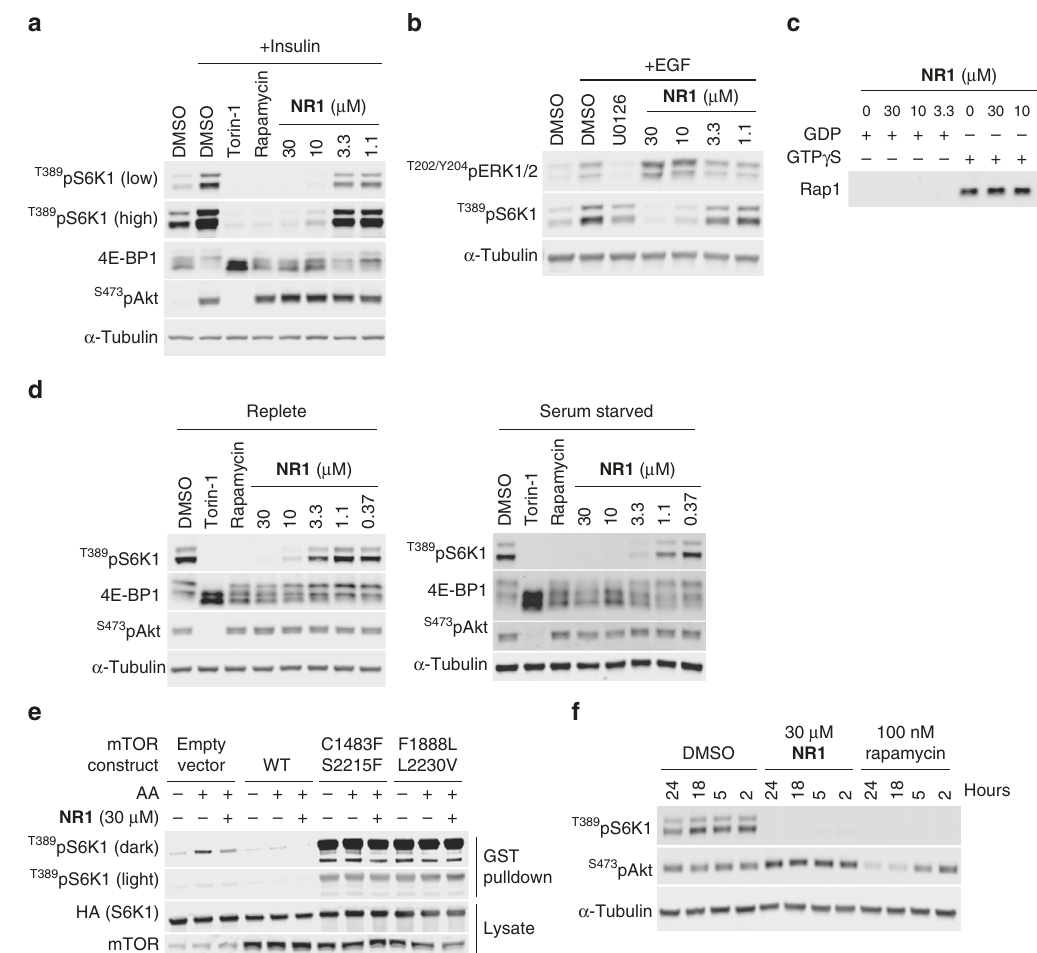
Fig. 4 NR1 selectively inhibits mTORC1 but not mTORC2 in cells. a , b Effect of NR1 on insulin-dependent activation of mTORC1 and EGF-dependent activation of T202/Y204 pERK1/2. MCF-7 cells were serum-starved for 16 h and treated with compound for 90 min before cell lysis and Western blot analysis. For insulin-stimulated cells, 100 nM insulin was added 30 min before cell lysis. For EGF-stimulated cells, 100 ng mL − 1 EGF was added 10 min before cell lysis. c Rap1 activity was detected in lysates loaded in vitro with either GDP or GTP γ S and treated with NR1 at the indicated concentrations. This was followed by a subsequent pulldown of GST-RalGDS-RBD. Bound Rap1 was detected by Western blot. d Evaluation of NR1 in a LAM patient-derived cell line (TRI102) under replete and serum-starved conditions. For replete conditions, TRI102 cells were treated for 90 min with compound in DMEM + 10% FBS. For serum-starved conditions, TRI102 cells were serum-starved 16 h and then treated for 90 min with compound prior to cell lysis and Western blot analysis. e HEK293 cells co-transfected with the indicated mTOR constructs and HA-GST-S6K1 were starved of amino acids or treated with NR1 . To assess mTORC1 activity, an HA IP was performed and Western blots probed for T389 pS6K1. f Chronic treatment of PC3 cells with NR1 to evaluate the inhibition of mTORC1 (using T389 pS6K1) versus mTORC2 (using S473 pAKT). PC3 cells were treated with compound under replete conditions for 24 h prior to cell